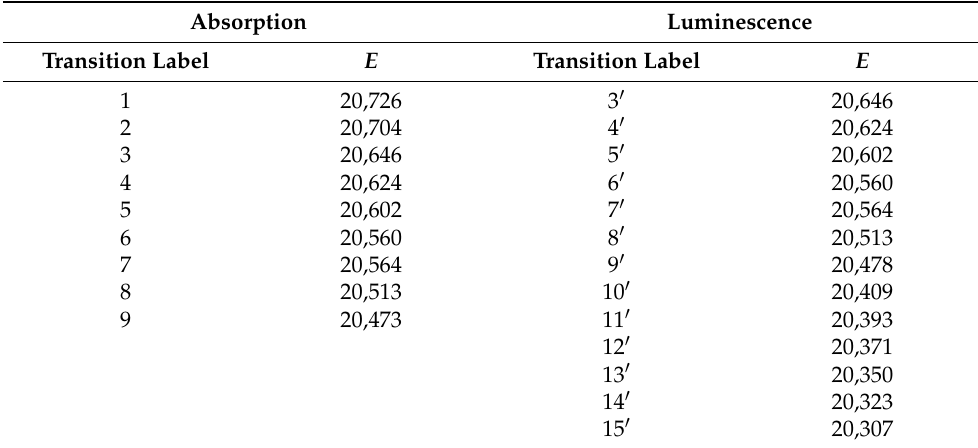
Table 1. The energy E (cm − 1 ) of optical transitions between the ground 7 F 6 and excited 5 D 4 multiplets of the Tb 3+ ion observed in the absorption and PL spectra of the KTF crystal at T = 90 K. Absorption